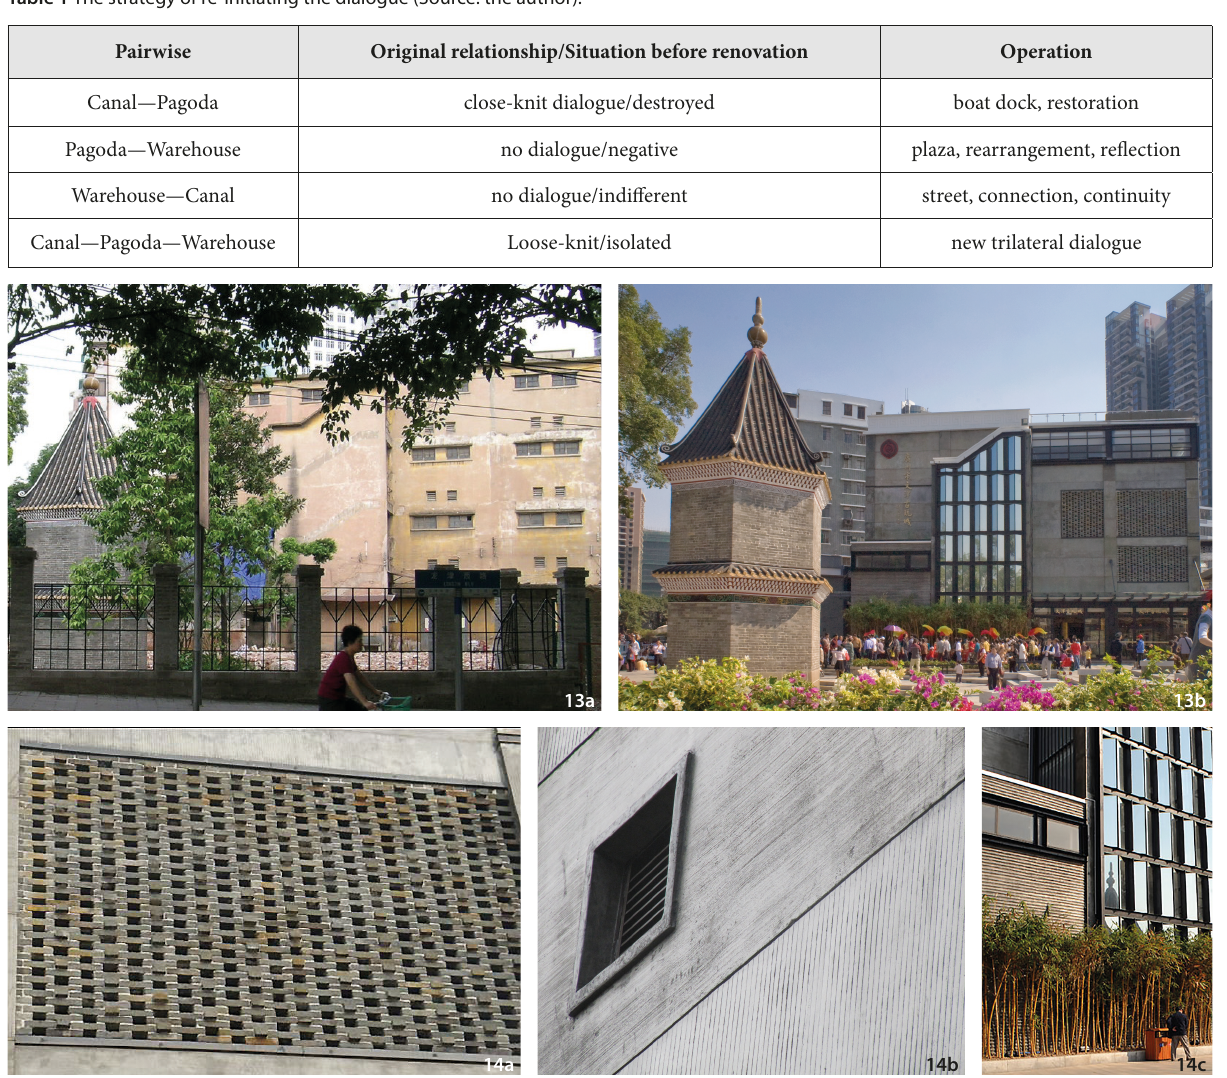
Table 1 The strategy of re-initiating the dialogue (Source: the author).